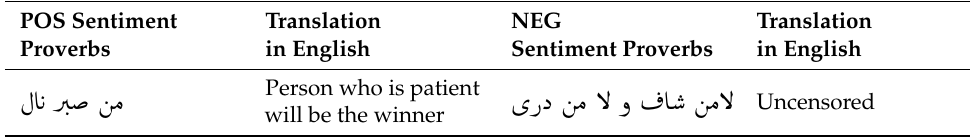
Table 12. POS and negative proverbs.